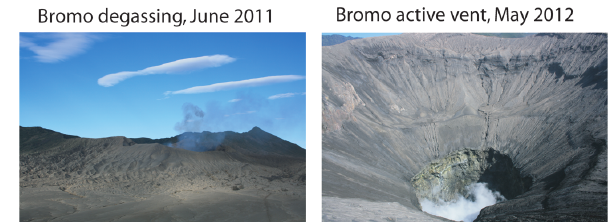
Fig. 6. Bromo degassing observed during two different periods. In June 2011 (left), during measurement, the degassing was clearly visible 2km from the volcano. In May 2012, there was no plume on Bromo and no SO 2 detected by DOAS. Only a stagnate white vapor was observed in the active crater